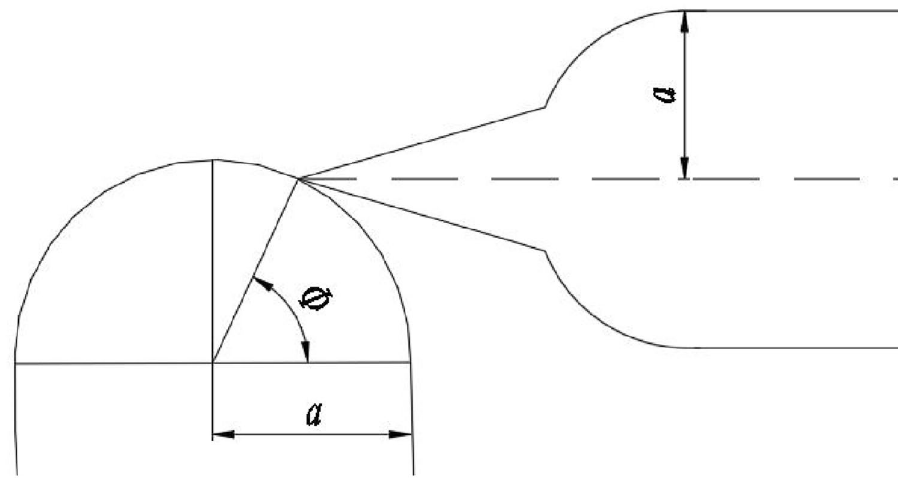
Figure 5. Schematic diagram of triangle buffer groove tangent to valve sleeve waist groove.